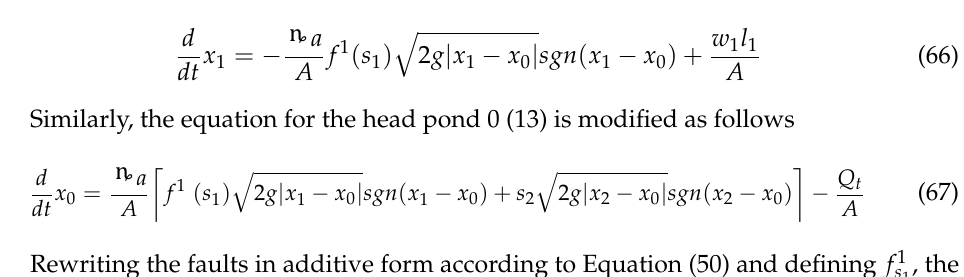
Figure 1. Three-pond hydraulic system.